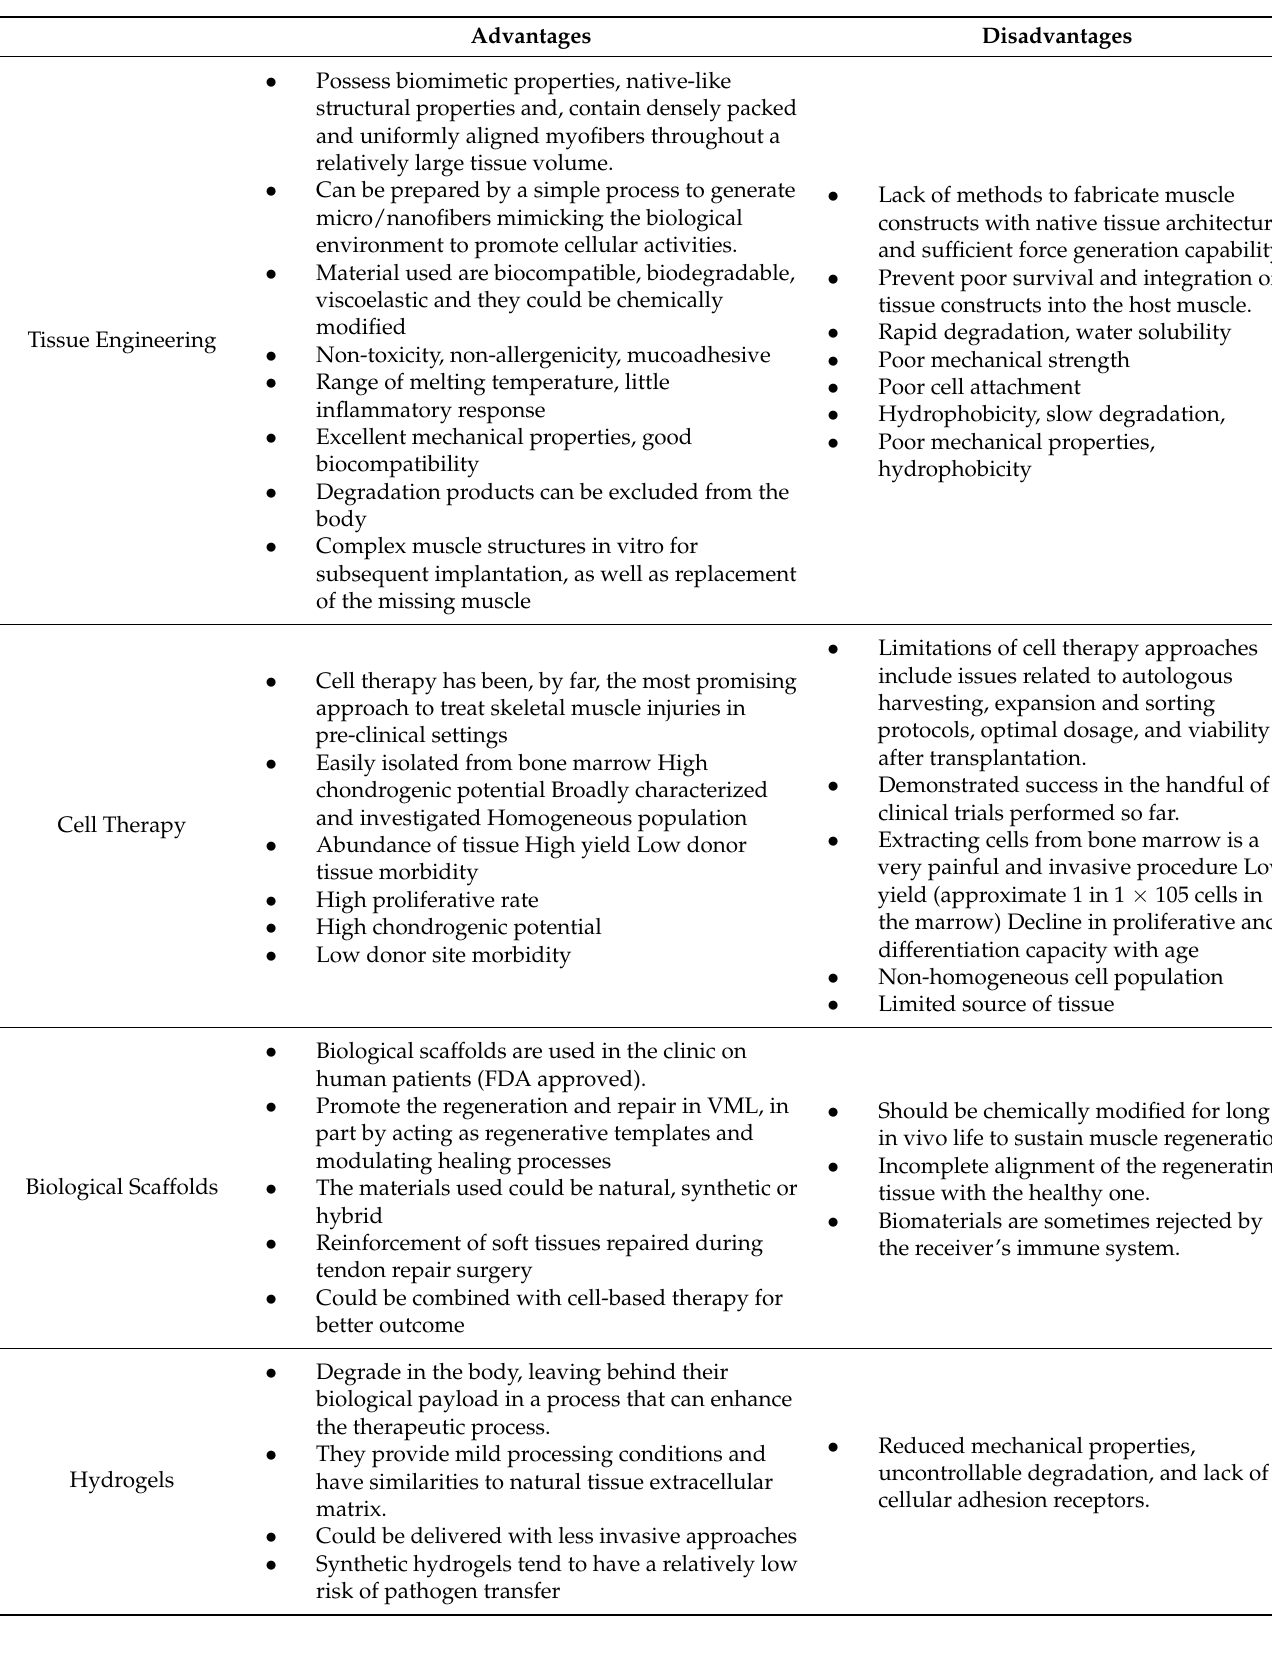
Table 1. Advantages and disadvantages of methodologies used in the therapy of